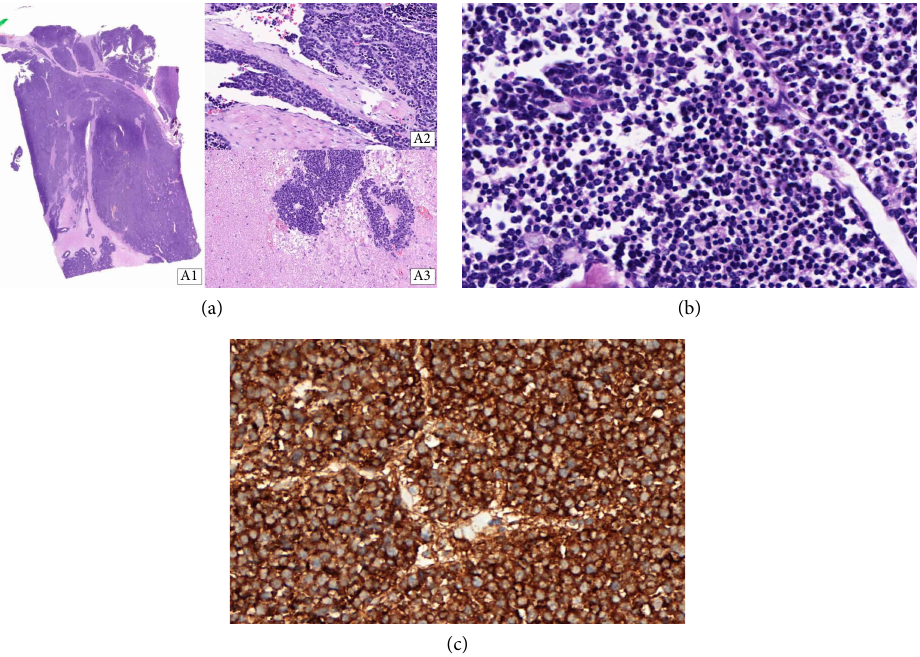
Figure 6: (a) (20x, H&E). A1—A tumor image which demonstrated the aggressiveness of the neoplasm. There is an expansive pattern of growing and the area of capsule infiltration. This area is the upper part of the figure. A2—Vascular infiltration by the tumor cells. A3—Necrosis and neoplasm. (b) (400x, H&E). The neoplasm has nuclear pattern of follicular carcinoma. There are no nuclear grooves or pseudo inclusions. Papillary differentiation was declined. (c) (400x, thyroglobulin). The lesion is positive in a diffuse pattern for thyroglobulin which confirms the thyroid